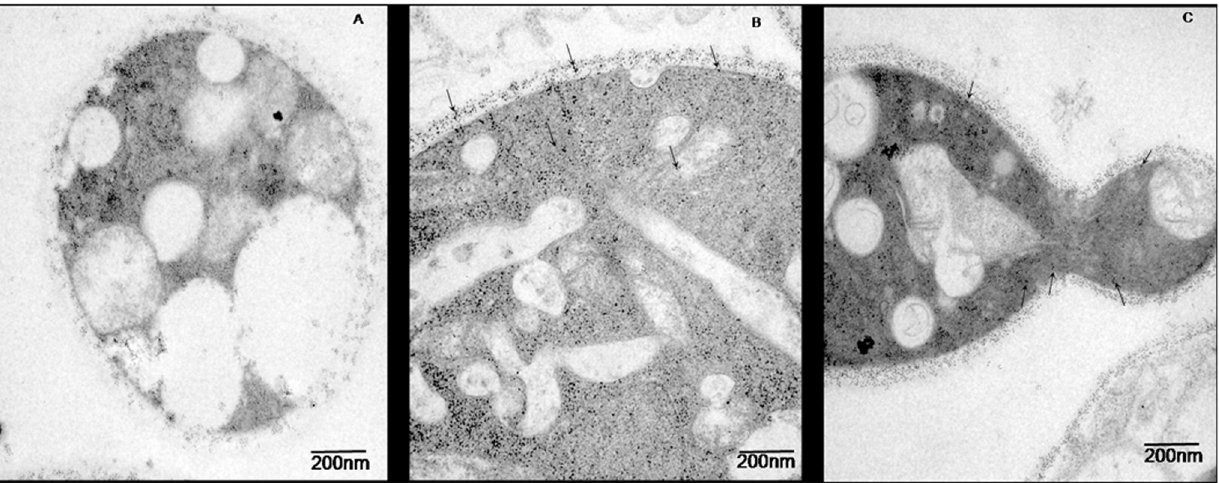
Figure 4. Immunoelectron microscopy to determine the localization of the 14-3-3 protein in yeast cells of P.brasiliensis . (A) The negative control was performed with pre-immune serum. (B) and (C) Labeling with the polyclonal anti-14-3-3 antibody. The arrows indicate the gold particles, demonstrating the sub-cellular localization of this protein. Magnification 25,000 6 .